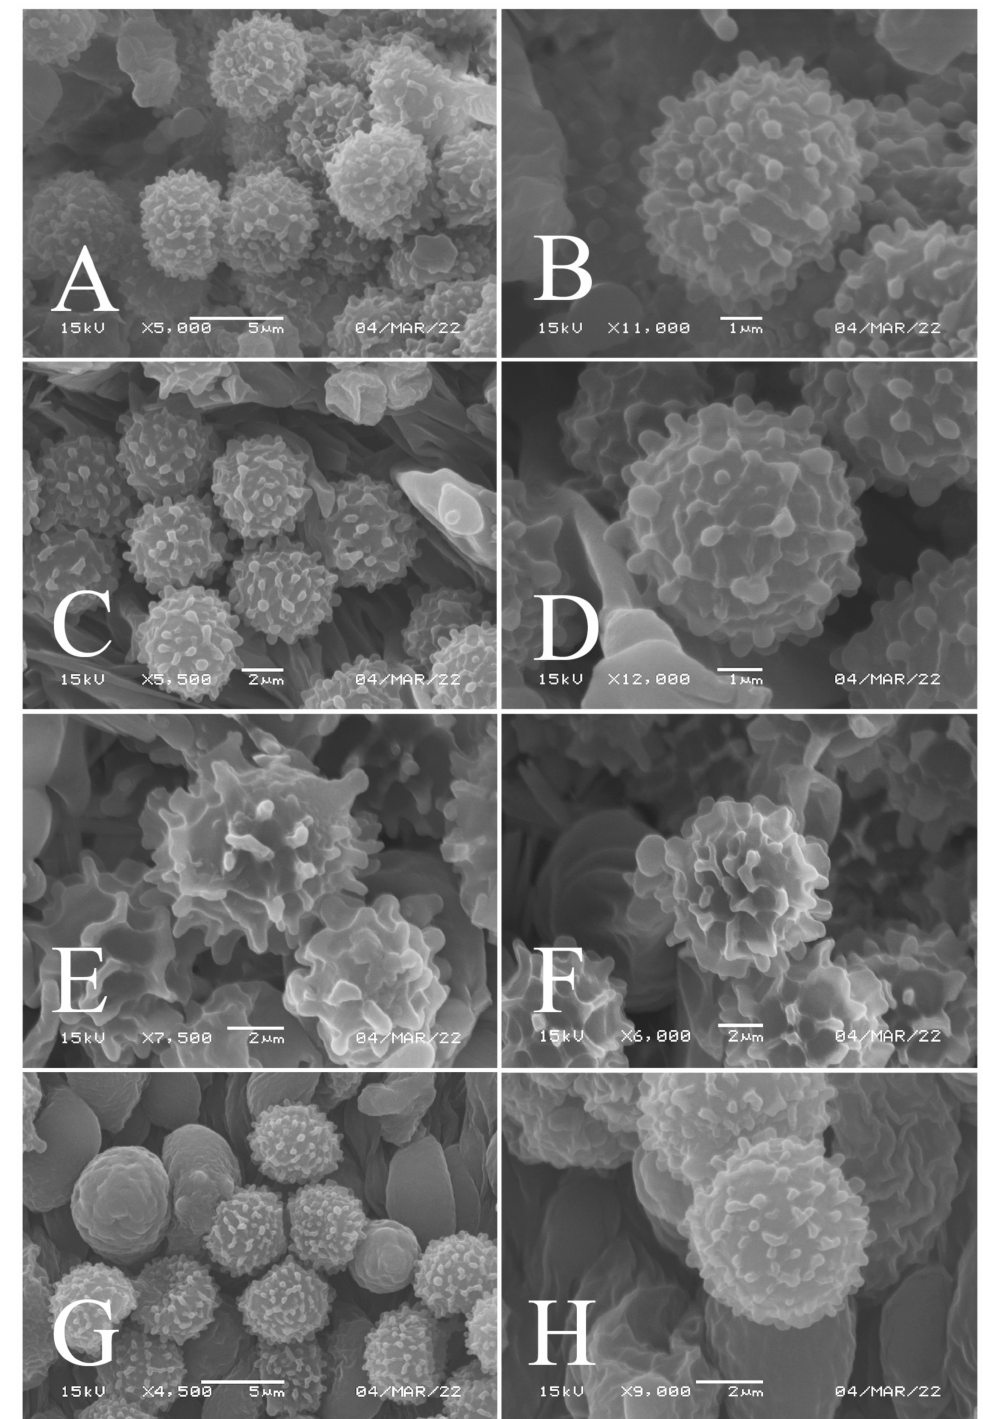
Figure 3. Basidiospores of four new species in SEM: ( A , B ) R. brevispora (HGASMF-009915, holotype); ( C , D ) R. flavescens (RITF5855, holotype); ( E , F ) R. longicollis (RITF5685, holotype); ( G , H ) R. pseudojapon- ica (RITF5755,